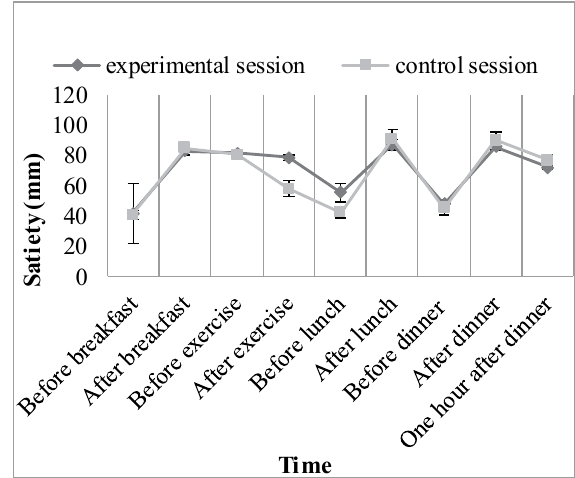
Figure 3 . Rating of satiety in the control and experimental session. Values are mean±SD (n=10).